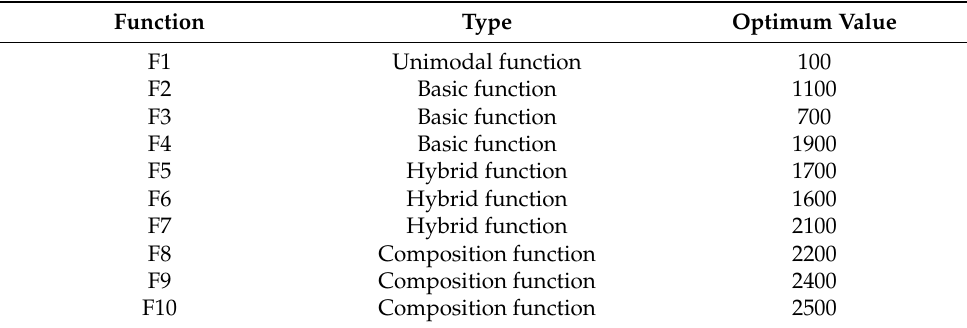
Table 3. Summary of the CEC 2020 benchmark functions.